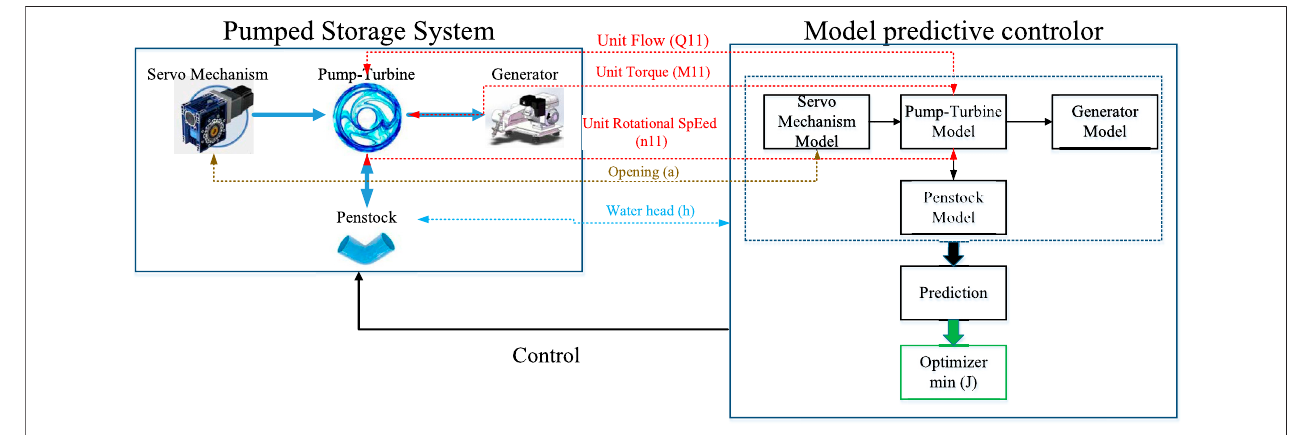
FIGURE 1 | The overall power storage system model predictive control